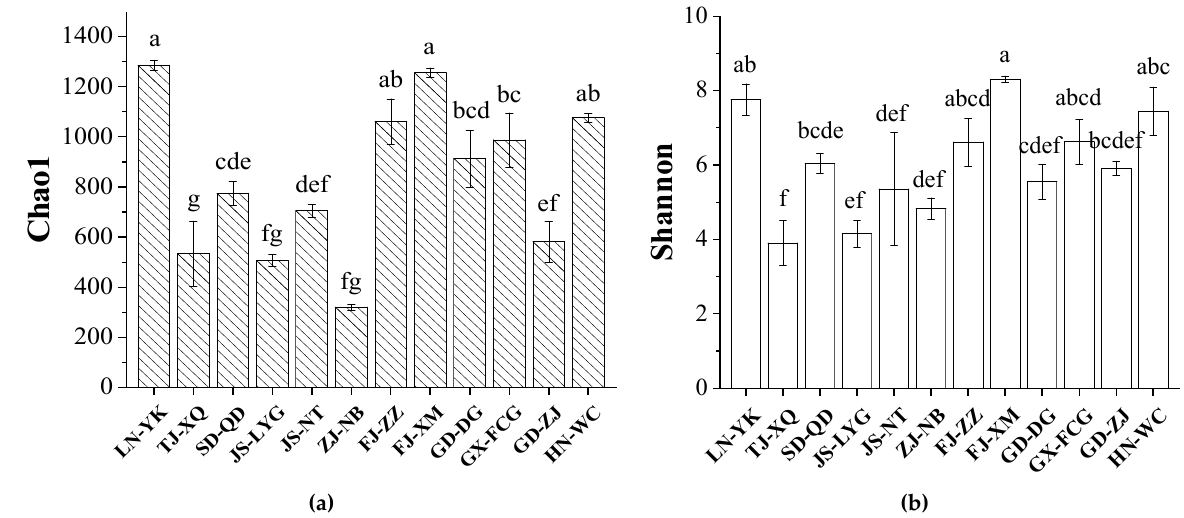
Figure 1. Alpha diversity (( a ) Chao1 richness estimator, ( b ) Shannon index) of intestinal bacteria among different samples (mean ± SE). Different letters indicate significant differences.